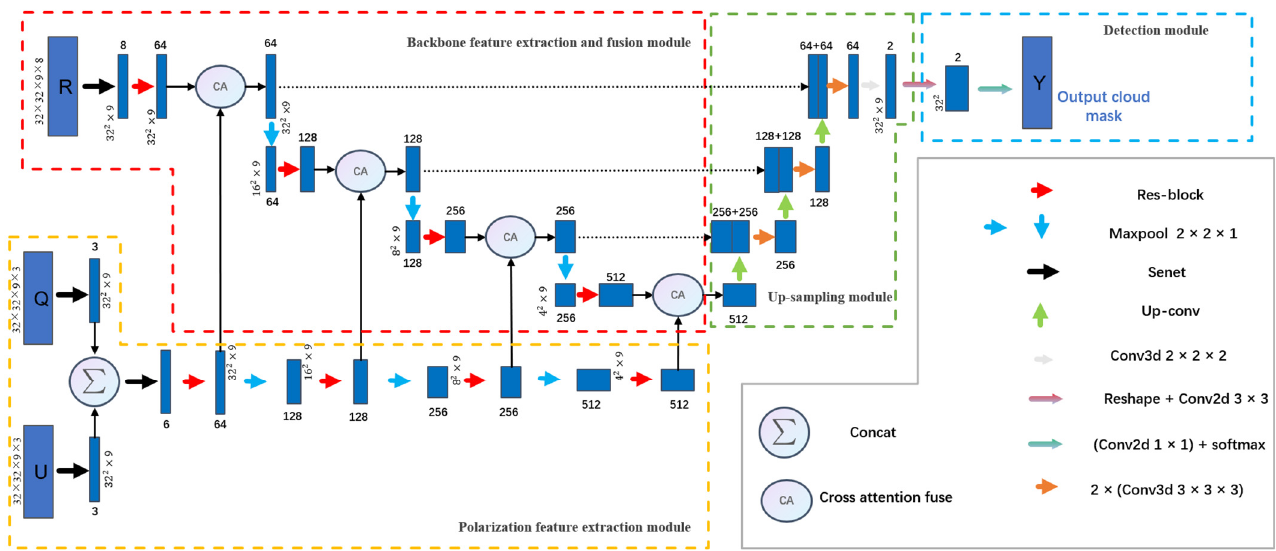
Figure 4. Schematic of MFCD-Net.